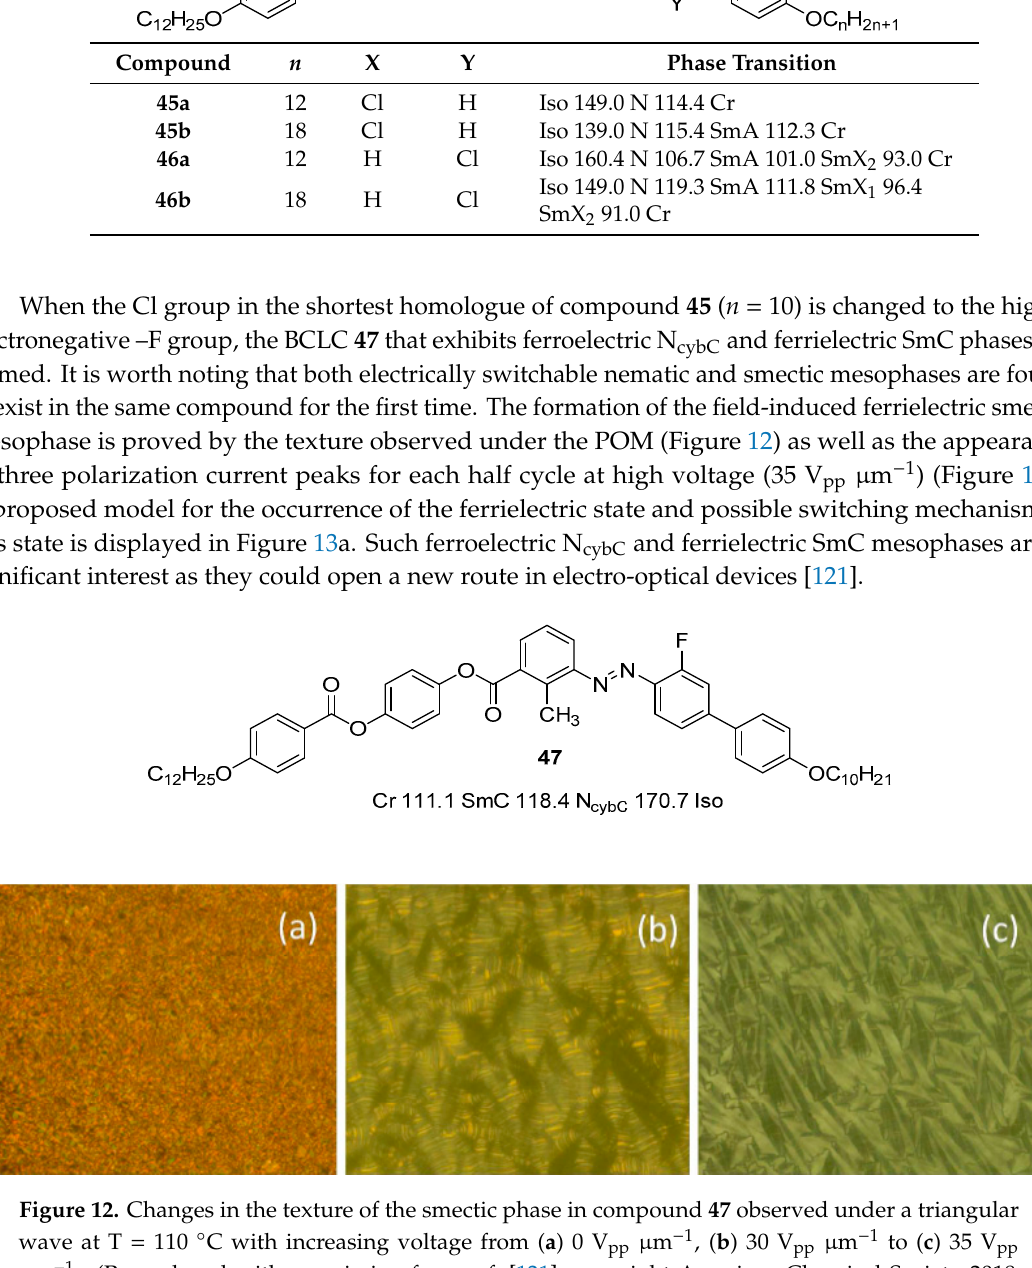
Figure 13. Layout diagram of ( a ) molecular organization of the layers and possible switching mechanism in ferrielectric state with increasing voltage as follows: Ferroelectric ( − ) → Ferrielectric ( − ) → Ferrielectric (+) → Ferroelectric (+) and ( b ) switching current response of compound 47 in the SmC phase at T = 110 °C under the high voltage of 35 V pp µm − 1. (Reproduced with permission from ref. [121], copyright American Chemical Society 2018, https://doi.org/10.1021/acs.jpcb.7b11733). 2.1.5. Other Aromatic Bent-Core Units Some other aromatic bent-core units are also used to synthesized azobenzene containing BCLCs, such as 2,7-dihydroxynaphthalene and 4-chloro-1,3-dinitrobenzene. For example, naphthalene based BCLC monomers incorporated with azobenzene units terminated with double bonds had been investigated by Lutfor et al. All homologues of compounds 48 ( n = 3–9) display the enantiotropic B 6 phases, except for shorter homologues with n = 1 and 2 that exhibit the nematic